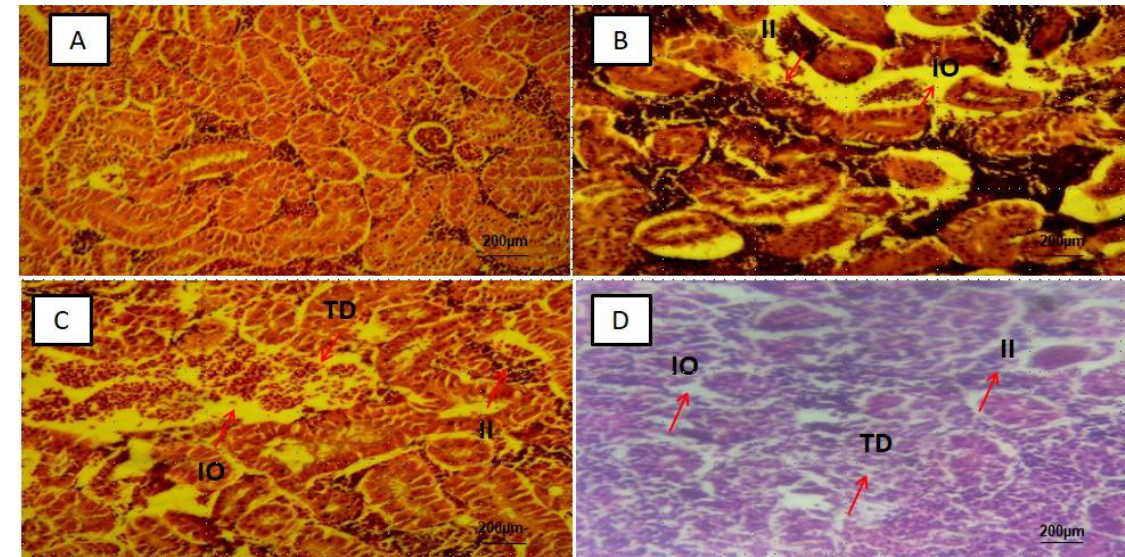
Figure 3. Representative photomicrograph of liver tissue: ( A ) Control group with normal liver tissue, ( B ) MP-LOW group showing liver parenchymal inflammation (LPI), ( C ) MP-MED group showing ballooning degeneration of hepatocytes (BD), and ( D ) MP-HIGH group showing hepatic necrosis (HN) and portal triaditis (TN).